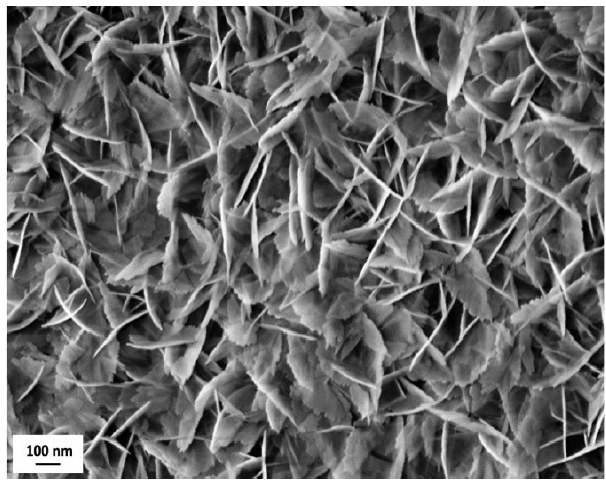
Figure 4. Field-emission scanning electron microscope (FE-SEM) image of flower like morphology obtained after coating the samples’ surface with the Al 2 O 3 nanoparticles sol, followed by the boiling treatment. Scale bar is reported.